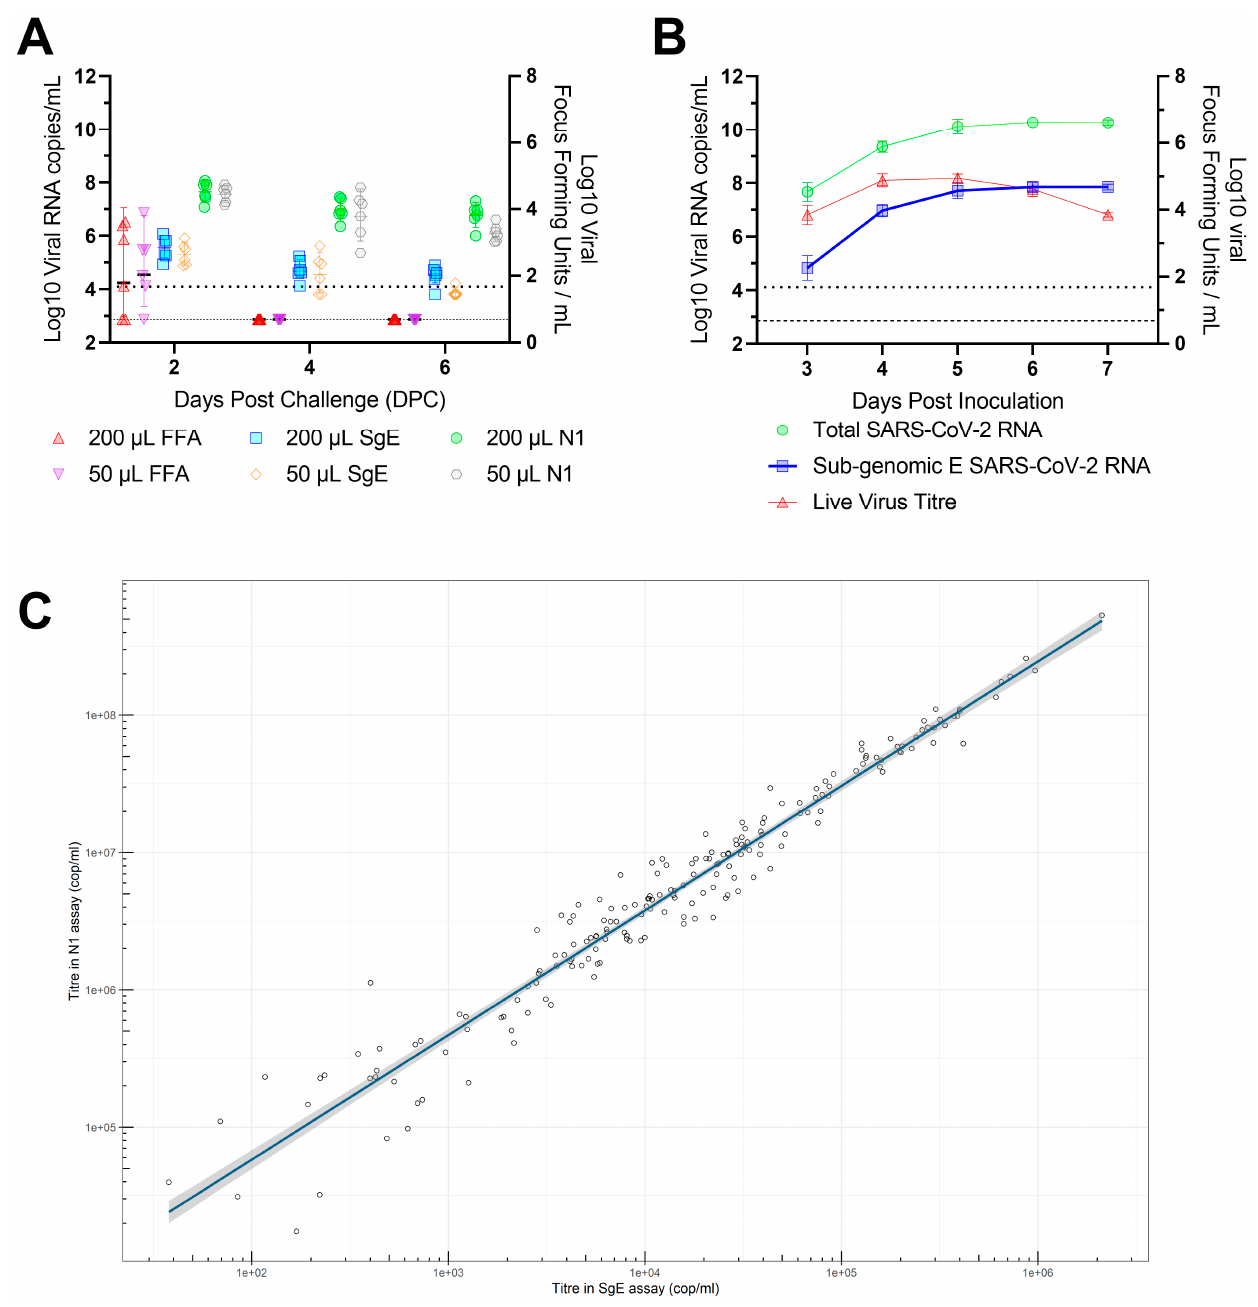
Figure 4. Sub-genomic vs total RNA titre in ex vivo/vitro samples. ( A ) Ex vivo comparison of total genomic viral titre by focus forming assay (FFA), sub-genomic E gene titre by PCR and live viral titre by N1 genomic PCR from 2, 4 and 6 days post challenge (DPC). Dotted line indicates the lower limit of quantification (LLOQ) for sub-genomic and viral PCR values below this are set to half LLOQ for graphing. Dashed line indicates the lower limit of detection (LLOD) for the focus forming assay. ( B ) In vitro comparison of total genomic, subgenomic and live virus titres cultured in Vero-E6 cells. Lines are means and error bars represent standard deviation. ( C ) Comparison of Viral RNA Copies/mL and Sub-genomic RNA copies/mL. Linear regression was used to assess the relationship between total viral RNA copies/mL and sub-genomic RNA copies/mL. The fitted regression model determined a Y-intercept of − 2.897, R2 of 0.95 ( p = 3.81 × 10 − 127 ).